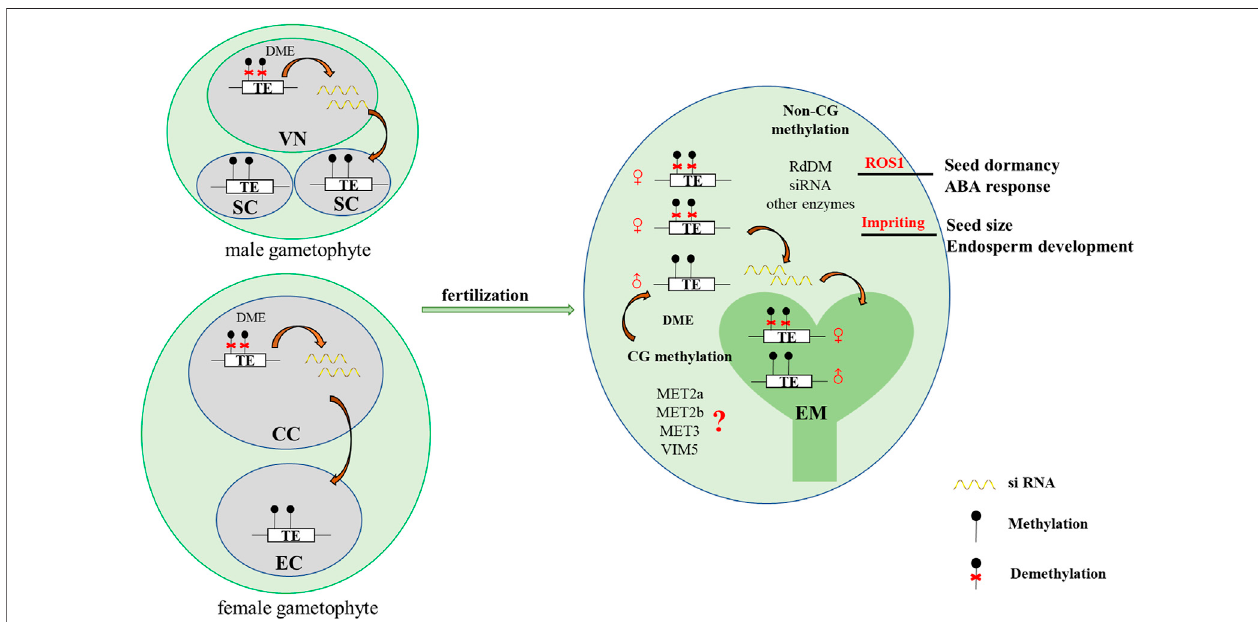
FIGURE 2 | A simpli fi ed model of DME-mediated DNA demethylation in Arabidopsis endosperm. Before fertilization, the central cell and vegetative cell are highly demethylated resulted from the action of DME. DME preferentially targets TE regions (Gehring et al., 2009; Hsieh et al., 2009; Ibarra et al., 2012). The vegetative cell produces siRNA into the sperm cells and maintains the sperm cell hypermethylation through the RDdM pathway (Martinez et al., 2016). So the methylation level in the endosperm is much lower than in the embryo after fertilization. The siRNAs produced by the demethylation of the endosperm are transferred to the embryo to maintain the stability of the embryo genome. MET2a, MET2b, MET3, and VIM5 may jointly regulate CG methylation in the endosperm. In addition, the differential methylation of the embryo and endosperm leads to imprinting in the endosperm, which may affect endosperm development and control seed size. Additionally, the